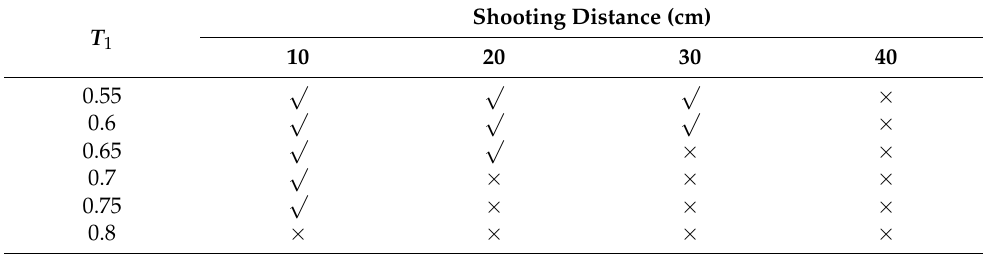
Table 3. Resynchronizing result of se with 9 × 9 Size.